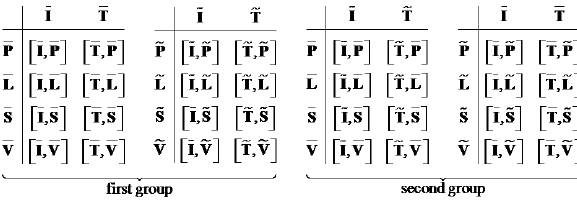
Figure 5: Classification of the space and time elements related to the physical